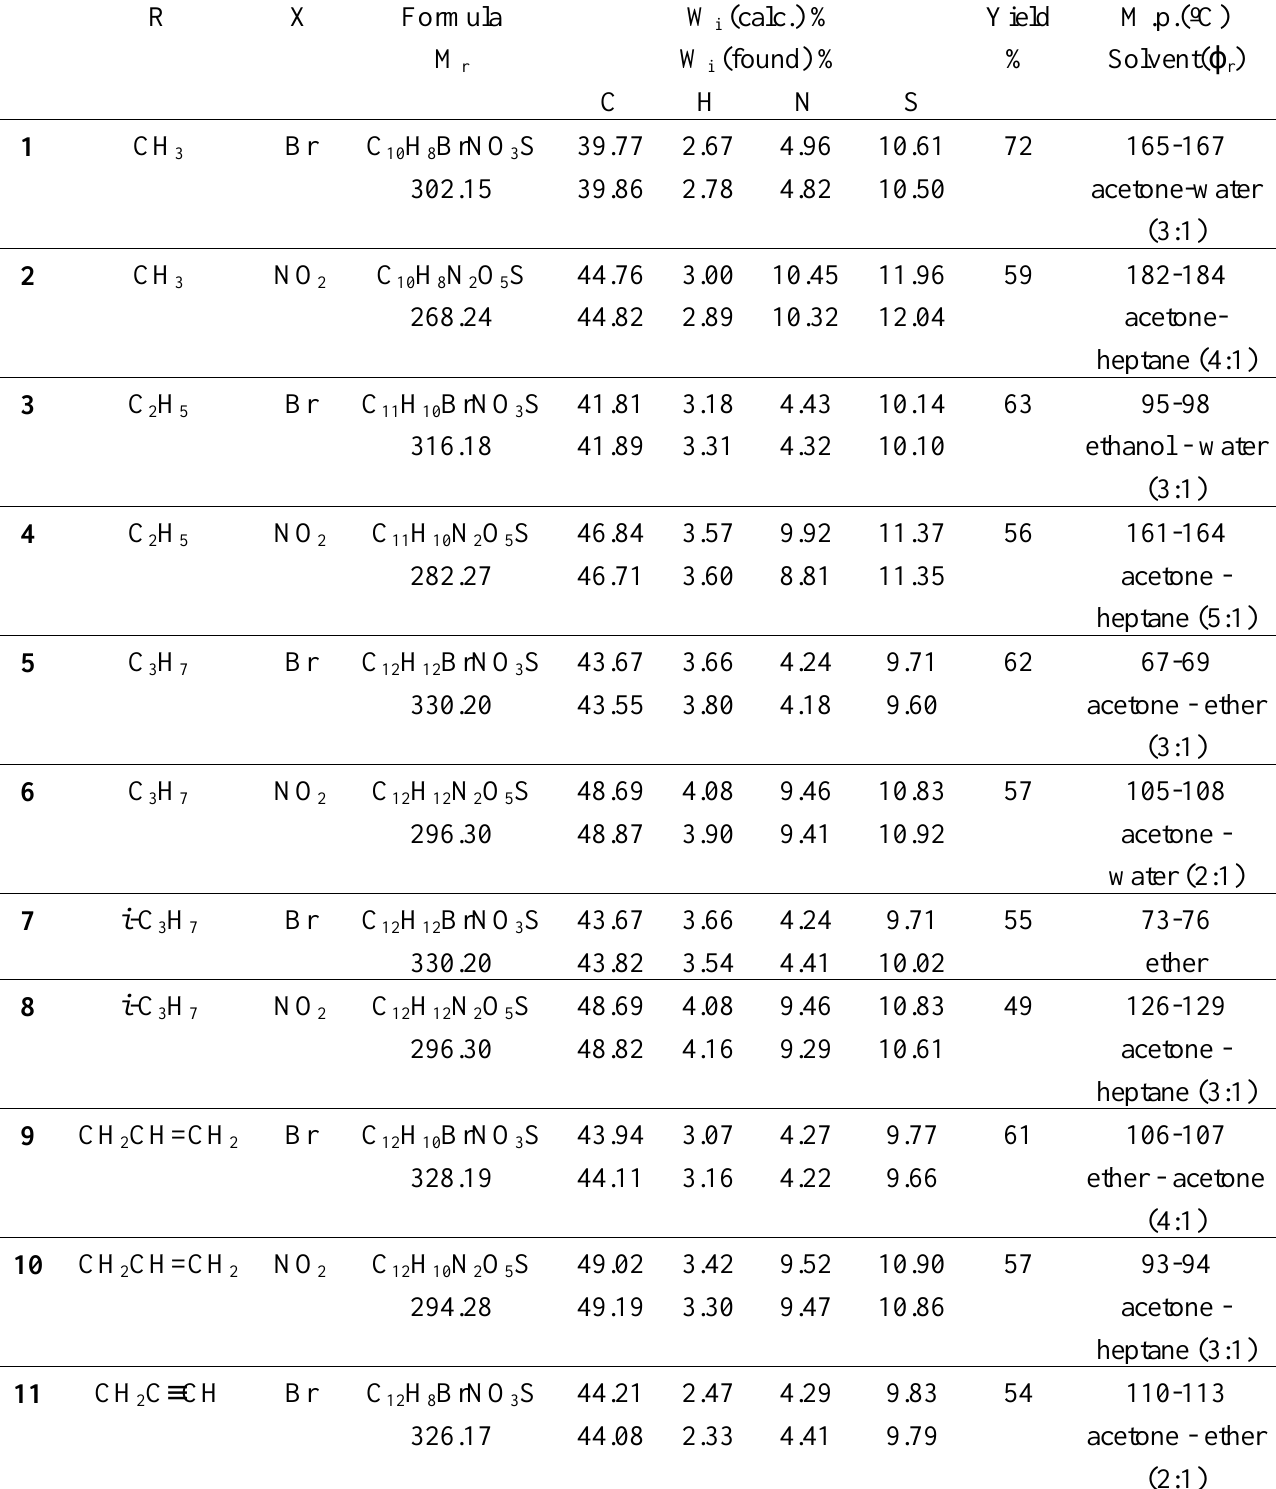
Table 4. Characterisation of the synthesized